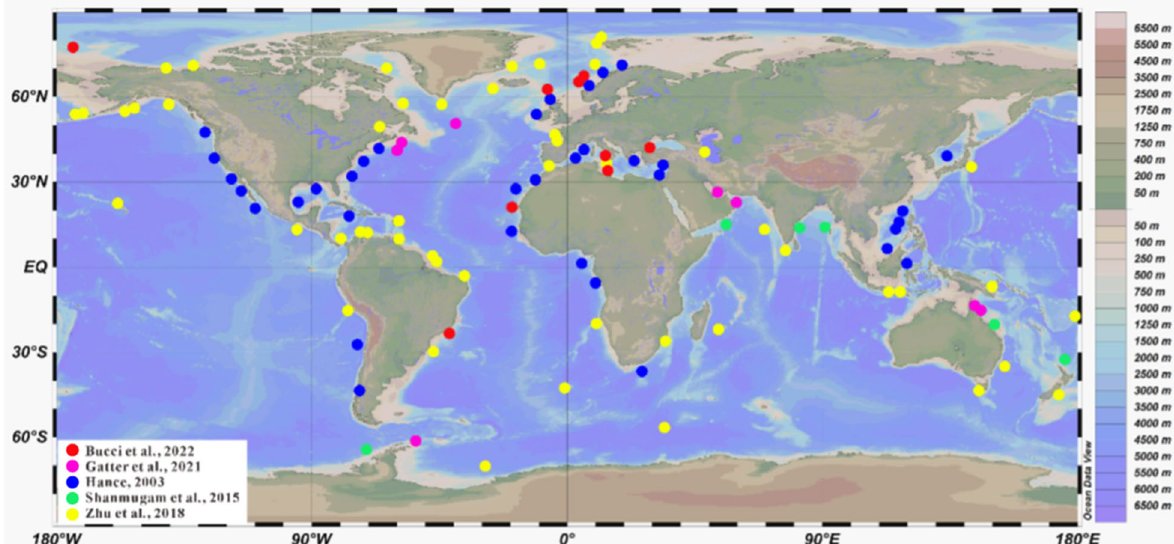
Fig. 3 Worldwide distribution of major submarine landslides (data from Bucci and Tuttleb 2022; Gatter et al. 2021; Hance 2003; Shanmugam and Wang 2015; Zhu et al.